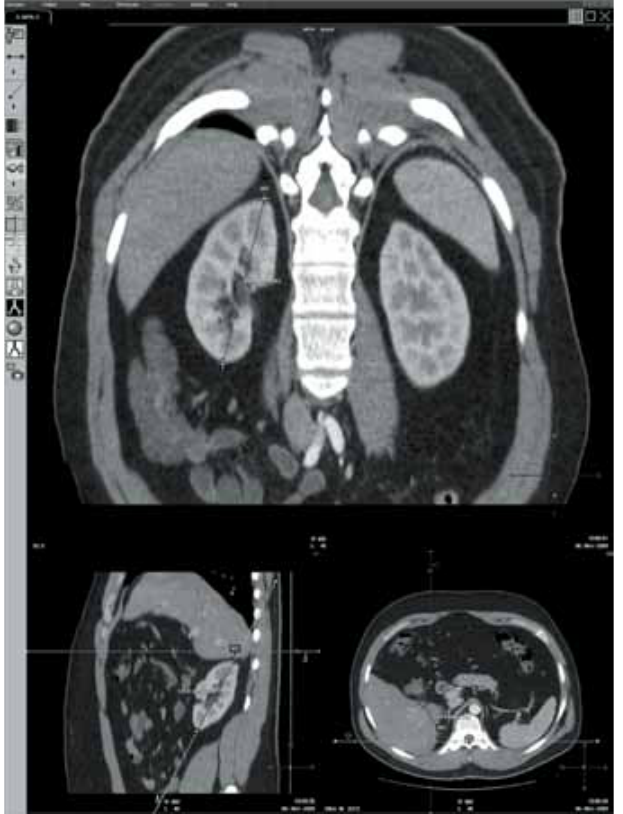
Fig. 1. Oblique coronal images used to measure maximum renal length.